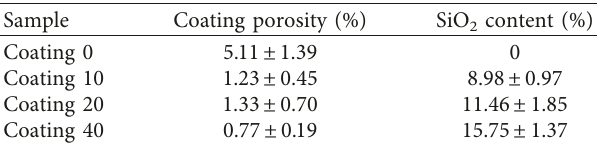
Table 1: Porosity and SiO